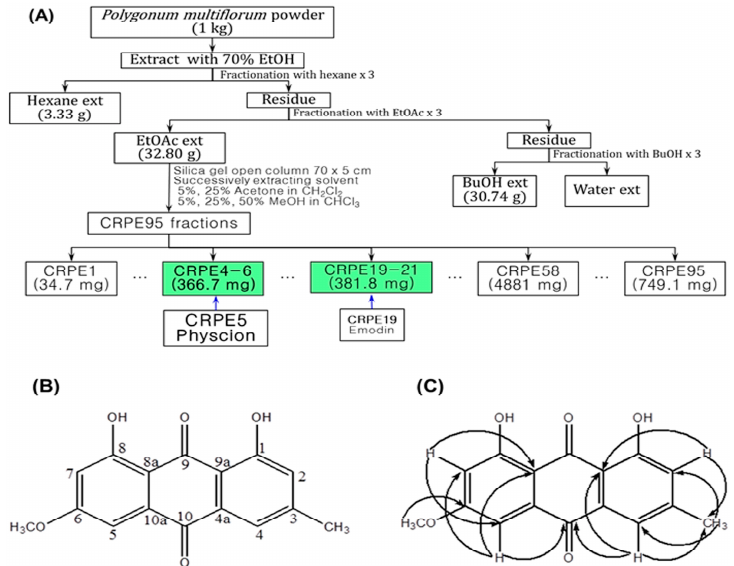
Figure 1. Purification chart ( A ); chemical structure ( B ); and key heteronuclear multiple bond correlation (HMBC) ( C ) of physcion from the ethyl acetate (EtOAc) extract of Polygonum multiflorum by silica gel column chromatography. CRPE is code name indicating ethyl acetate extract from Polygonum multiflorum . Physcion (CRPE5) and emodin (CRPE19) were finally isolated from CRPE4-6 and CRPE19-21 fractions, respectively.